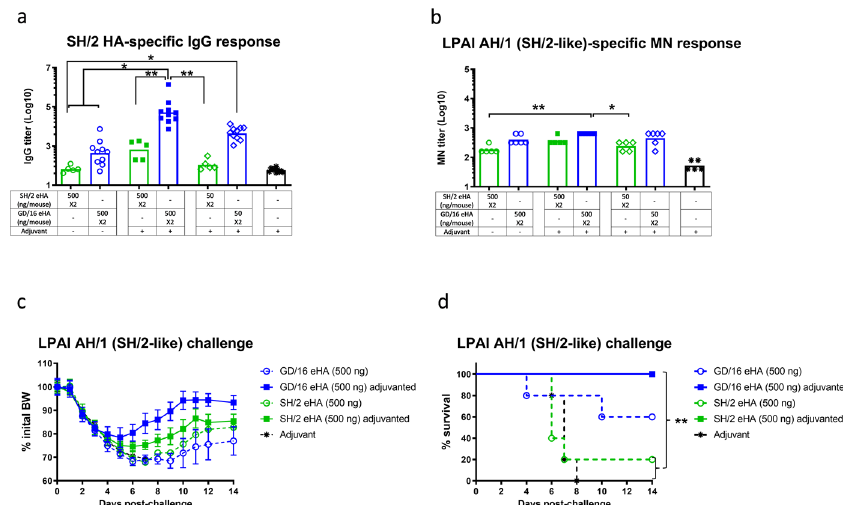
Fig. 1 Immunogenicity and protection against low pathogenic avian in fl uenza H7N9 virus of the fi rst wave. BALB/c mice were immunized twice with HA extracted (eHA) from H7N9 candidate vaccine viruses A/Shanghai/2/2013 (SH/2) or A/Guangdong/17SF003/2016 (GD/16) with or without adjuvant. Immunized mice were challenged with low pathogenic avian in fl uenza (LPAI) wild type (wt) H7N9 A/Anhui/1/2013 (AH/1, SH/2-like) of the fi rst wave in a BSL-3 + biocontainment. ( a ) IgG ELISA titers against SH/2 HA; ( b ) microneutralization (MN) titers against LPAI wt AH/1 virus; ( c ) body weight (BW) and ( d ) survival after LPAI wt AH/1 challenge. Individual titers with geometric mean (bars) are shown ( n = 5 – 10 mice/group). BW data are expressed as mean ± s.e.m ( n = 5 mice/group). * p < 0.05 and ** p < 0.01 by Kruskal-Wallis test with Dunn ’ s multiple comparisons after log transformation (antibody responses) or by Log-rank (Mantel-Cox) test (survival